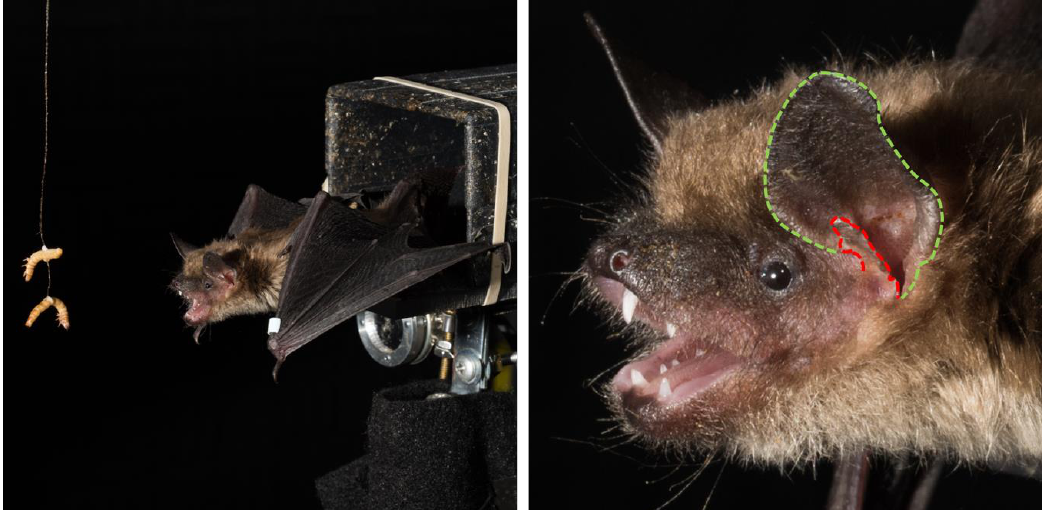
Figure 1. Eptesicus fuscus bat. Left panel: Bats are trained to perch on a platform and produce echolocation calls to track and intercept approaching targets (mealworms). This experimental setup allows us to study bat sonar tracking behavior while maintaining careful control of the target motion. Right panel: Closeup of the head of the bat, showing details of the external ear anatomy. A green dashed line delineates the left pinna, which acts as a receiver and can be independently moved to control inter-aural di ff erences, necessary for azimuthal localization of targets [24]. The red dashed line delineates the enlarged tragus, which contributes to target elevation estimation. Photos courtesy of Dr. Brock Fenton.